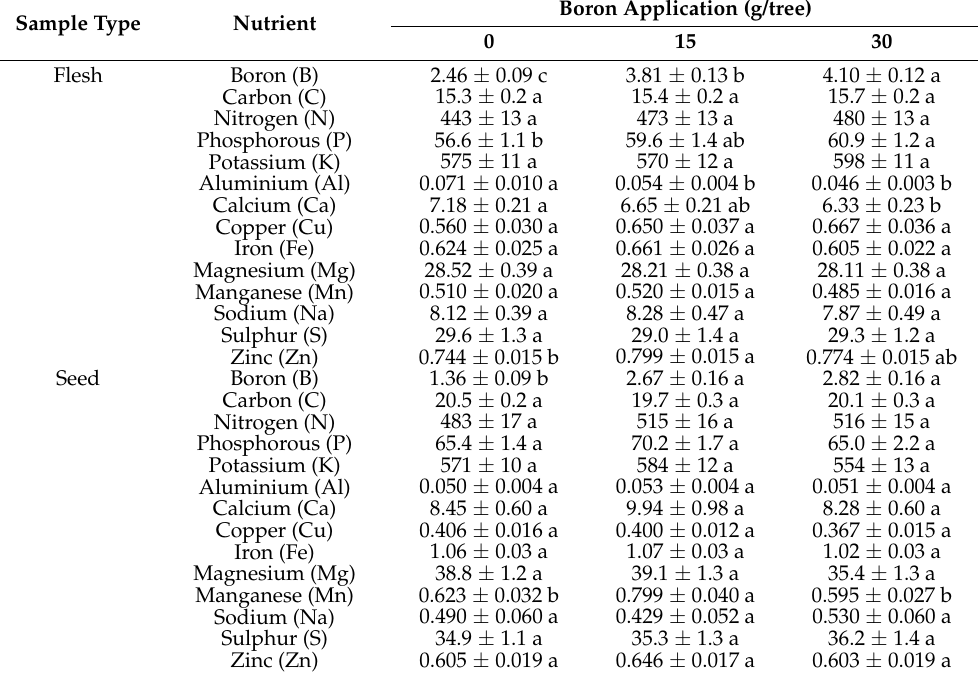
Means ± SE within a row with different letters are significantly different (generalised linear models, p < 0.05, n = 160 fruit for length, diameter, and seed mass, n = 80 fruit for flesh mass). Table 2. Mineral nutrient concentrations * in the fruit flesh and seed from Hass avocado trees treated with 0, 15 or 30 g boron per tree prior to peak anthesis.